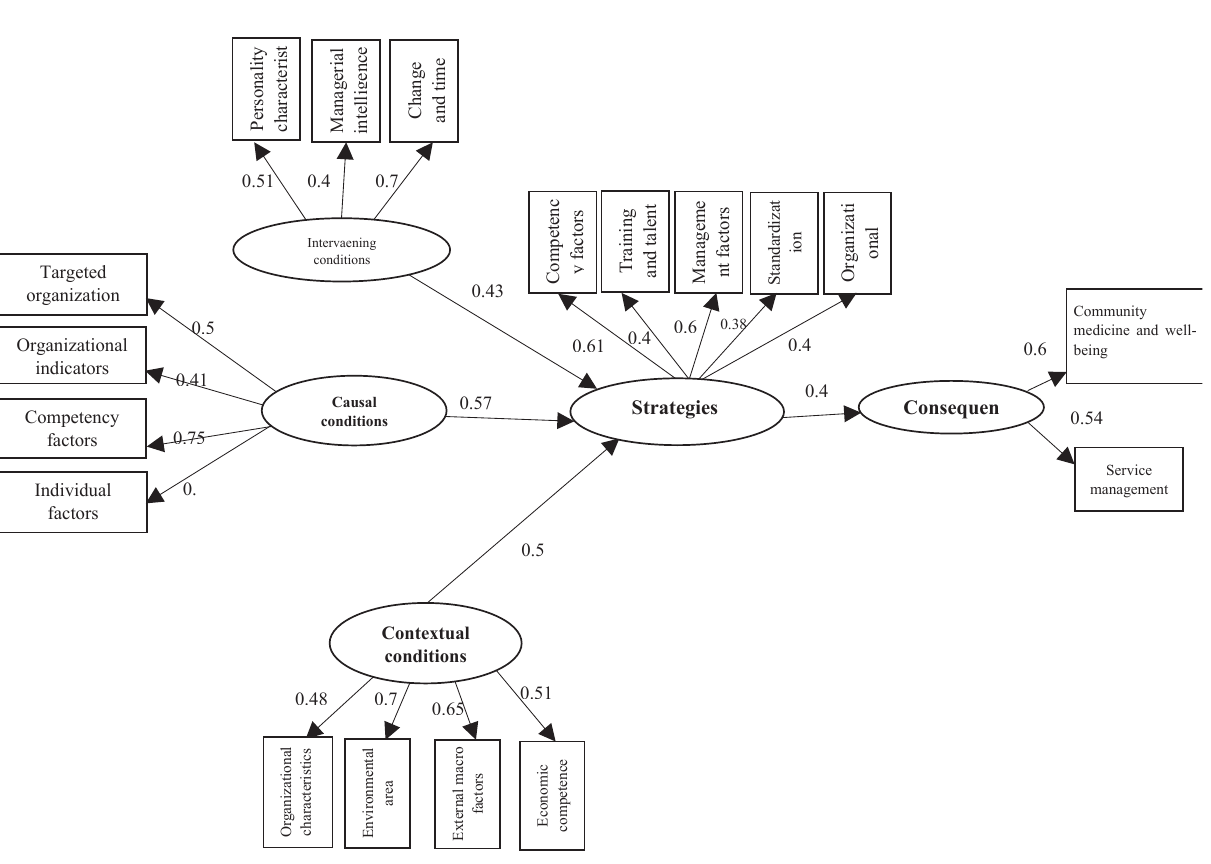
Figure 1. Structural equation model of senior managers’ competencies